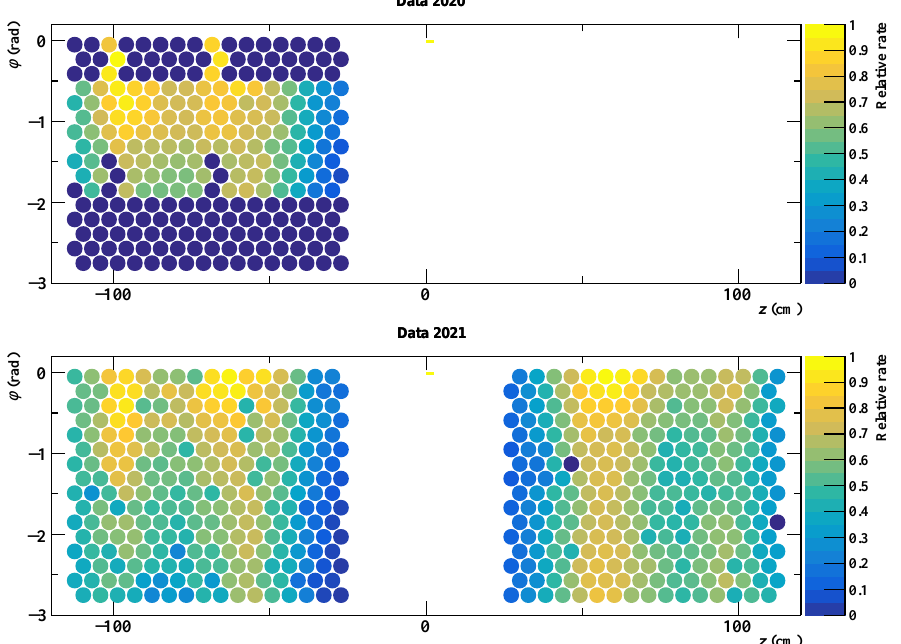
Figure 7. Relative hit rate of the pTC tiles in 2020 ( top ) and 2021 ( bottom ) runs.